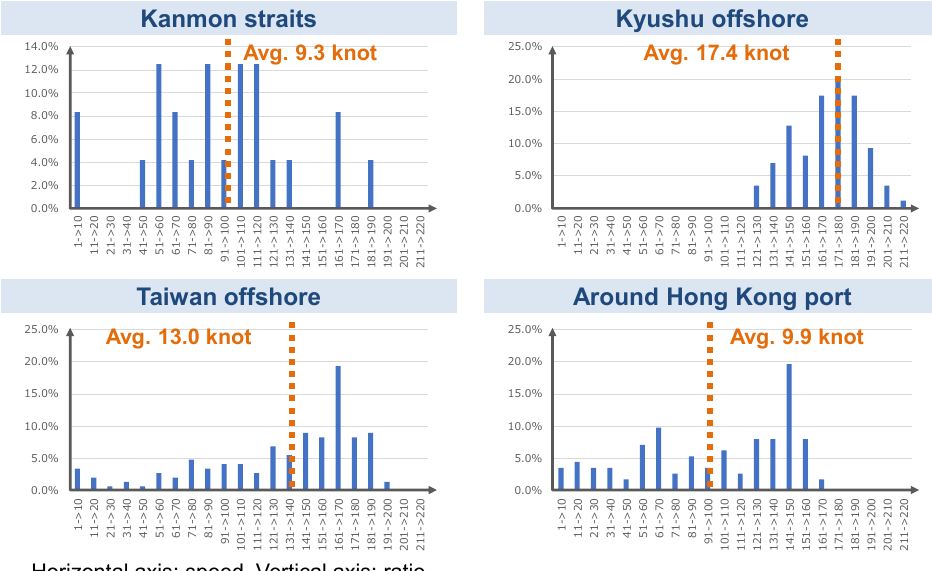
Figure 2. Voyage speed distribution for various areas.